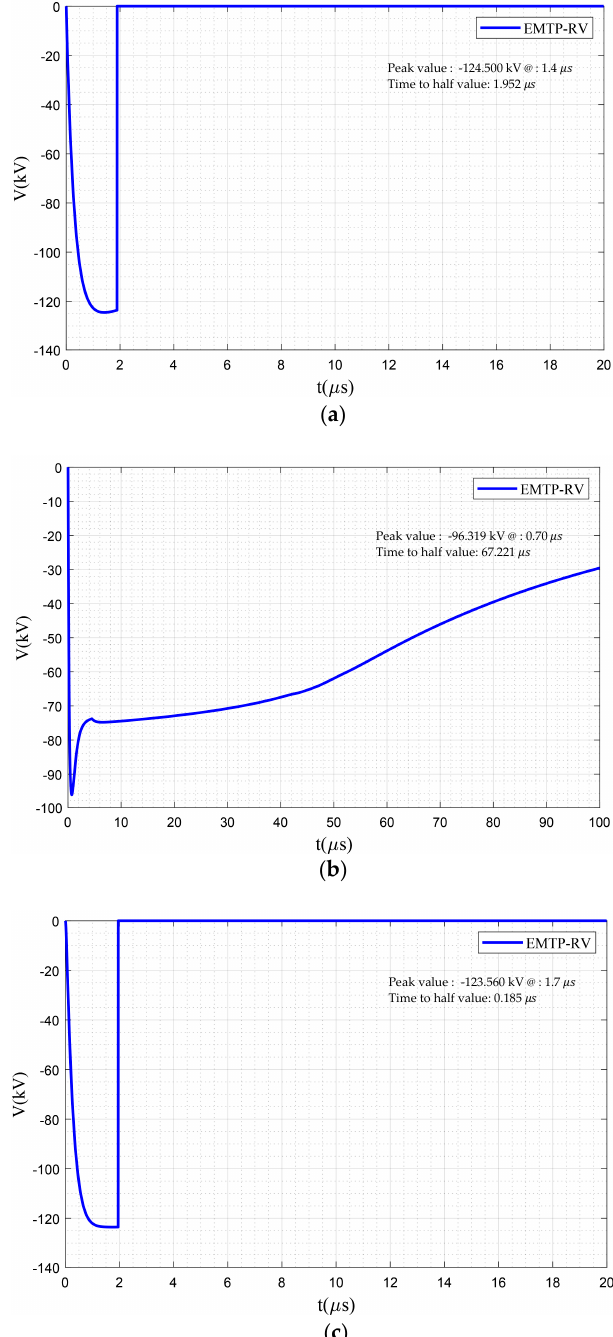
Figure 22. Applied impulse 125 kV in the presence of the ( a ) spark gap, ( b ) surge arrester, and ( c ) filtered spark gap.